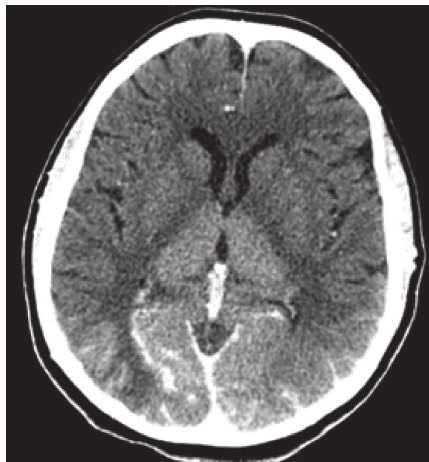
Figure 1: CT (axial) obtained one hour after DSA shows bilateral symmetrical contrast enhancement in parieto-occipital cortex and subarachnoid spaces, as well as in thalami.